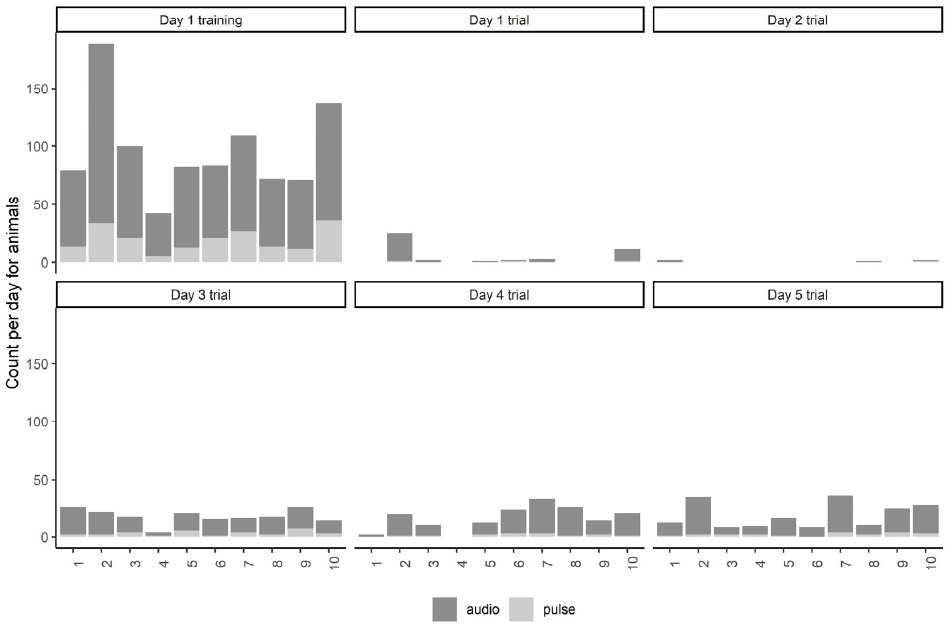
Figure 6. The total number of audio cues and electrical pulses per individual animal across each day of the trial at Lameroo, including during the initial training period on day 1. The incursion period where animals crossed into the exclusion zone on the third night (01:00–09:00) is not displayed (mean data for this period are presented in Table 1).